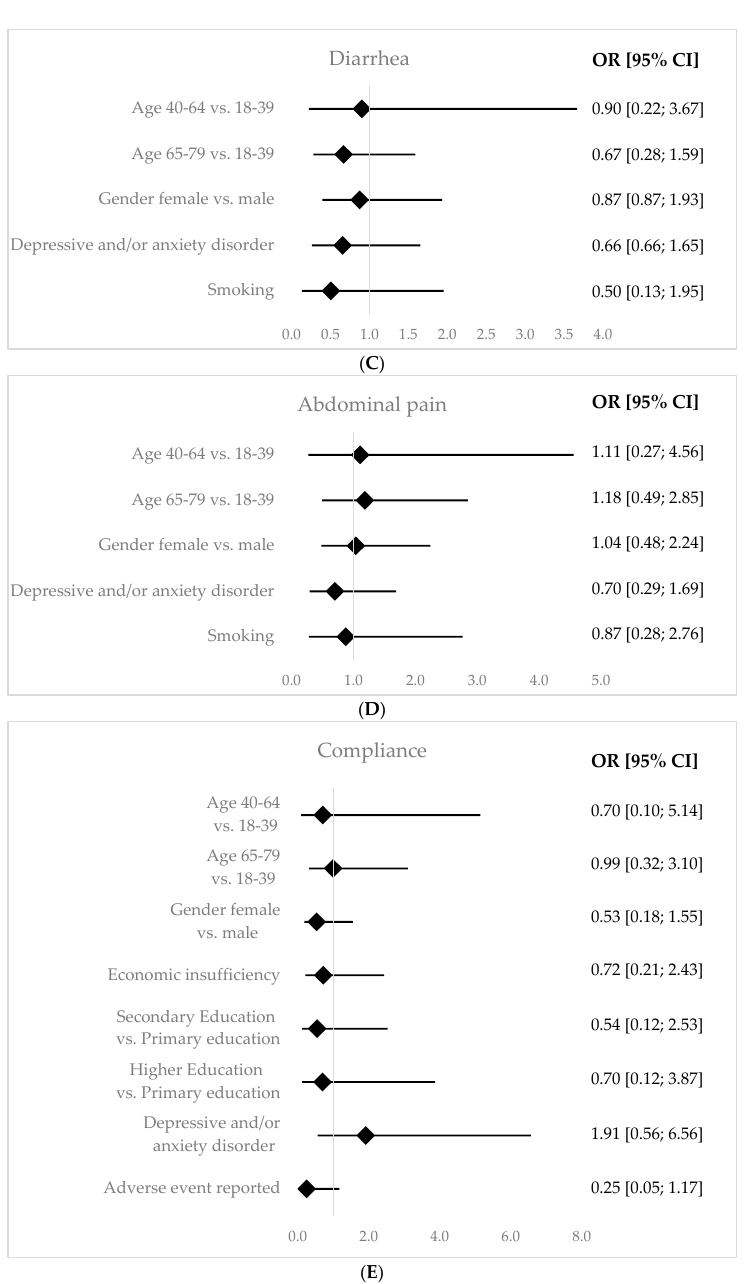
Figure 2. Forest plot charts for multivariable analysis of adverse outcomes and scheme compliance for quadruple therapy with bismuth: nausea ( A ), metallic taste ( B ), diarrhea ( C ), abdominal pain ( D ), scheme compliance ( E ). (CI—Confidence Interval; OR—Odds